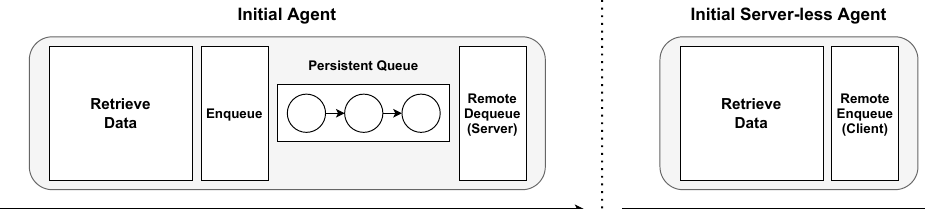
Figure 8. Initial worker agents. This type of agent is used to initiate one or several pipelines. This is achieved by having the agent continuously retrieve data from a source and then forward it to either a local (see left figure), or a remote (see right figure) queue.